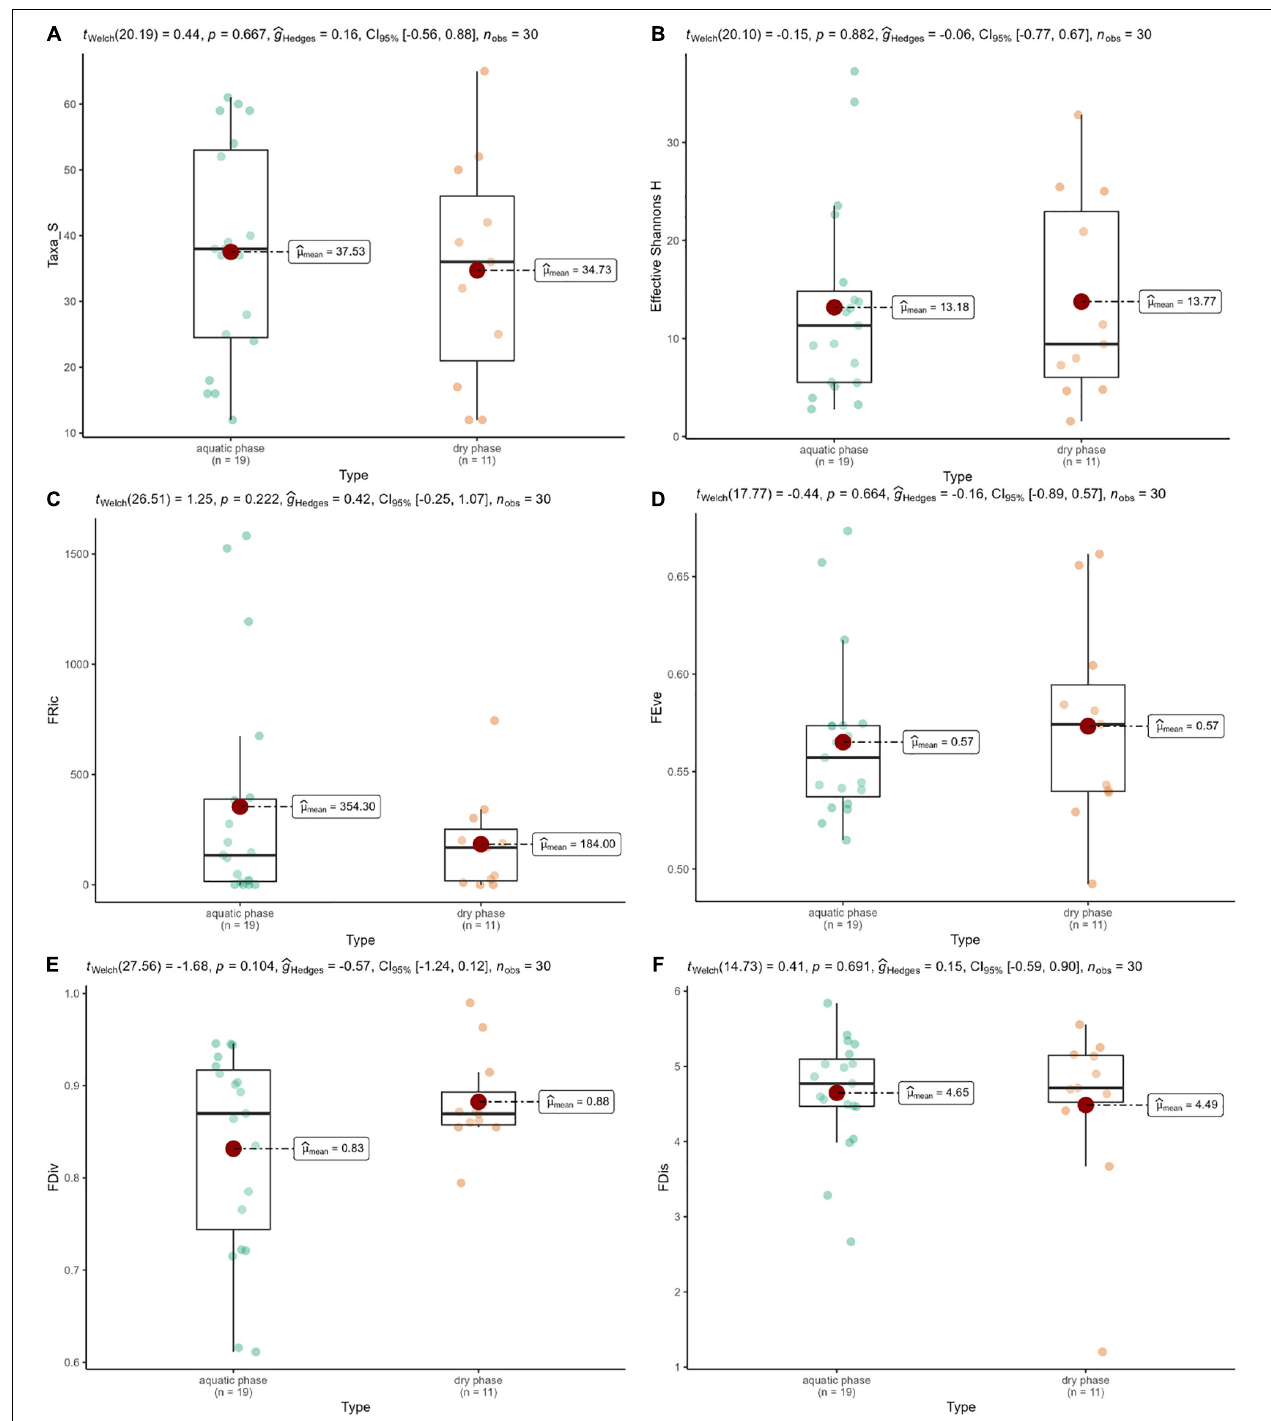
FIGURE 4 | Taxa_S (A) , effective Shannon’s H (B) , functional richness (C) , functional evenness (D) , functional divergence (E) , and functional dispersion (F) in the dry and aquatic phases. Results of ANOVA tests: p > 0.05 in all cases.